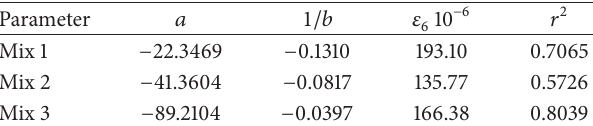
Table 3: Ascertained fatigue parameters for mixtures with recycled material.